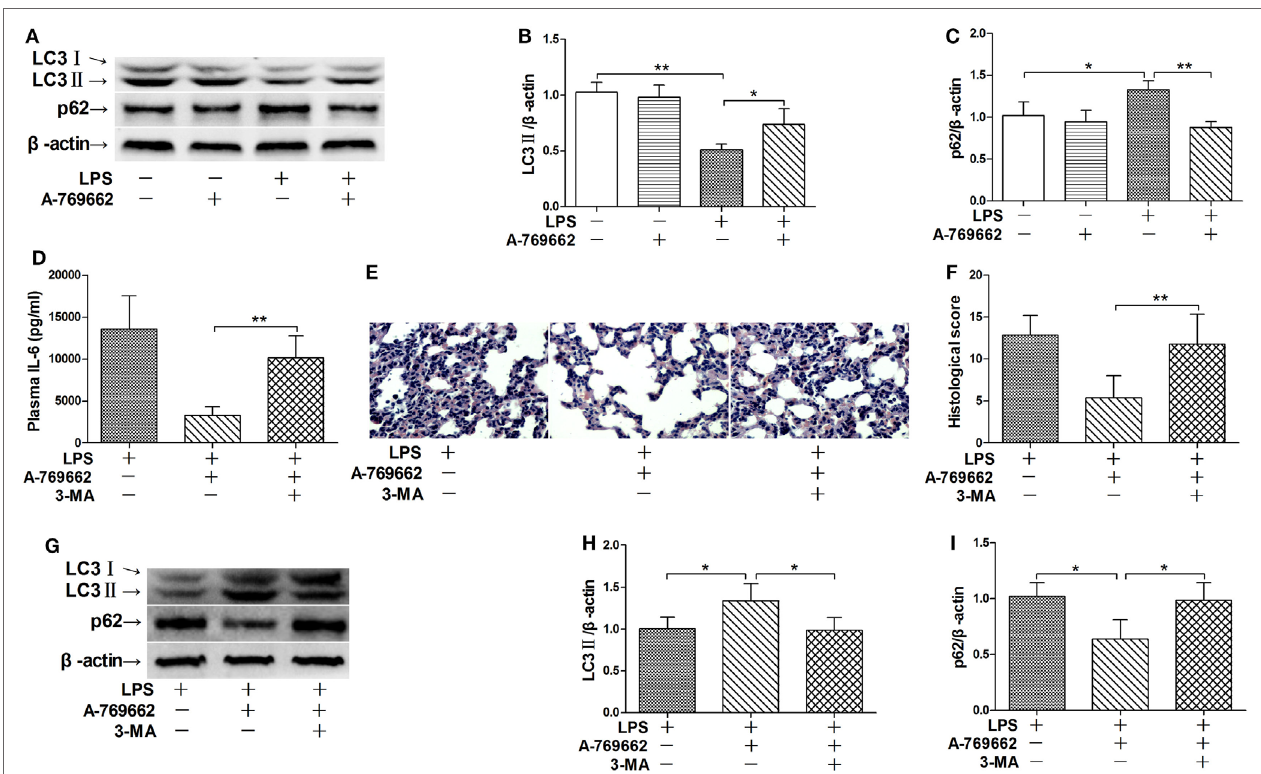
FigUre 3 | Inhibition of autophagy reversed the beneficial effects of AMP-activated protein kinase (AMPK) activator on inflammatory injury. (a–c) Mice were exposed to lipopolysaccharide (LPS) (20 mg/kg) with vehicle or AMPK activator A-769662 administration. The level of LC3II and p62 was determined by immunoblot (a) , and the blots were semi-quantified (B,c) ( n = 4). (D–i) Mice were exposed to LPS (20 mg/kg) with vehicle, AMPK activator A-769662, and autophagy inhibitor 3-MA administration. The plasma level of interleukin 6 (IL-6) was determined by enzyme-linked immunosorbent assay (D) ( n = 8). The histological abnormalities of the lung tissue were observed with (h,e) staining. The representative lung sections of each group were shown (e) , the histopathological alterations were blindly scored (F) . The level of LC3II and p62 was determined by immunoblot (g) , and the blots were semi-quantified (h,i) ( n =